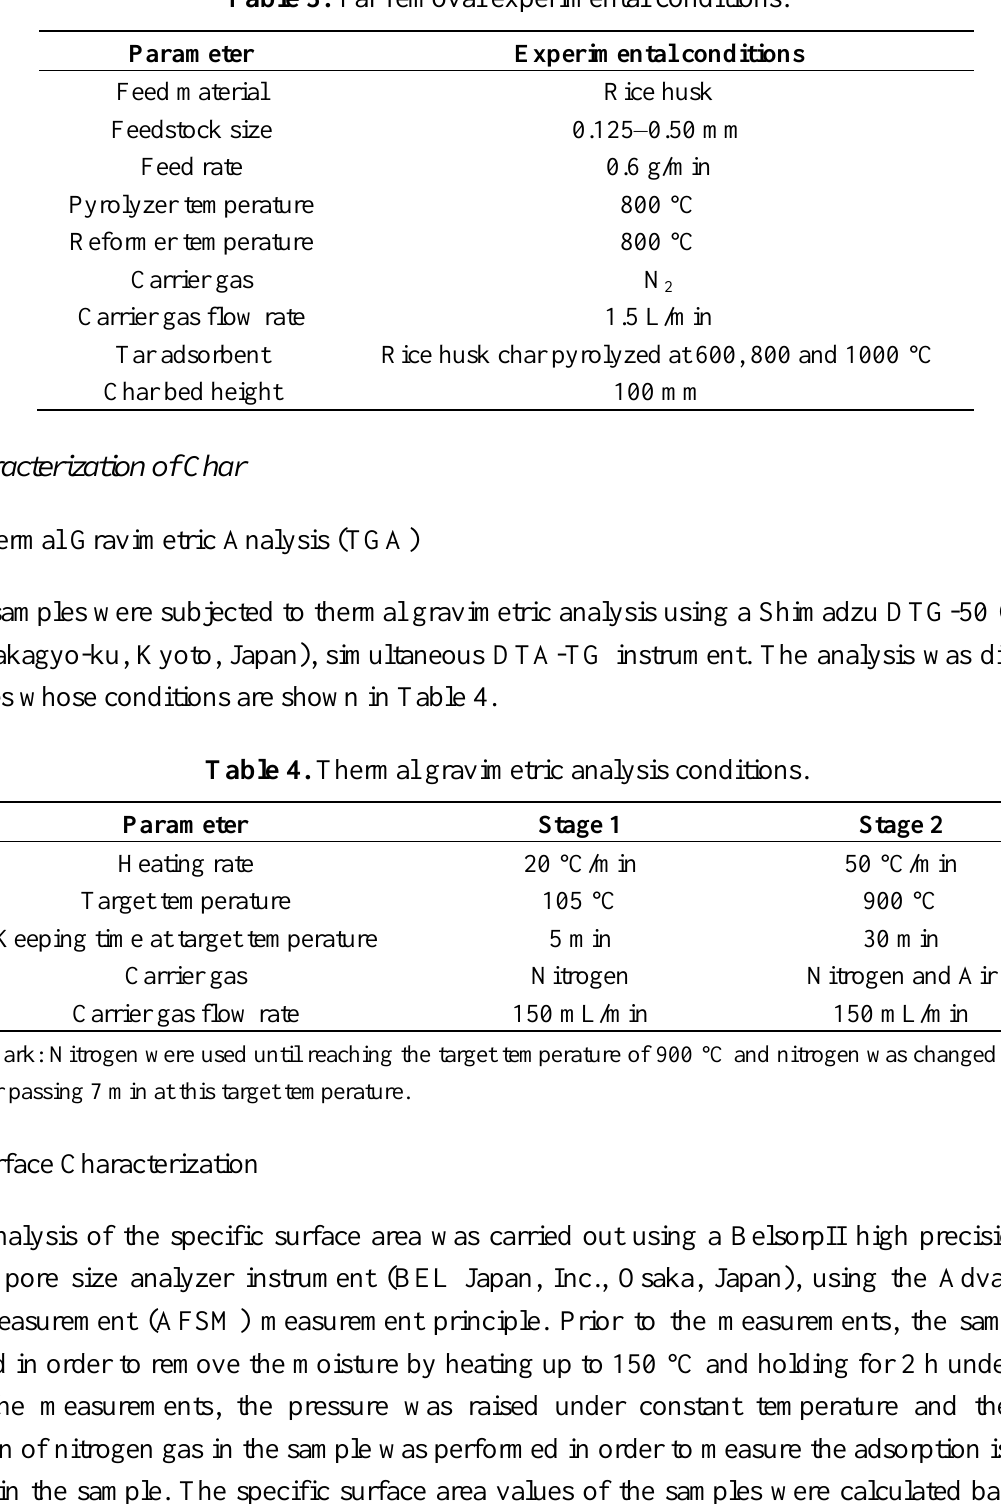
Table 3. Tar removal experimental conditions.